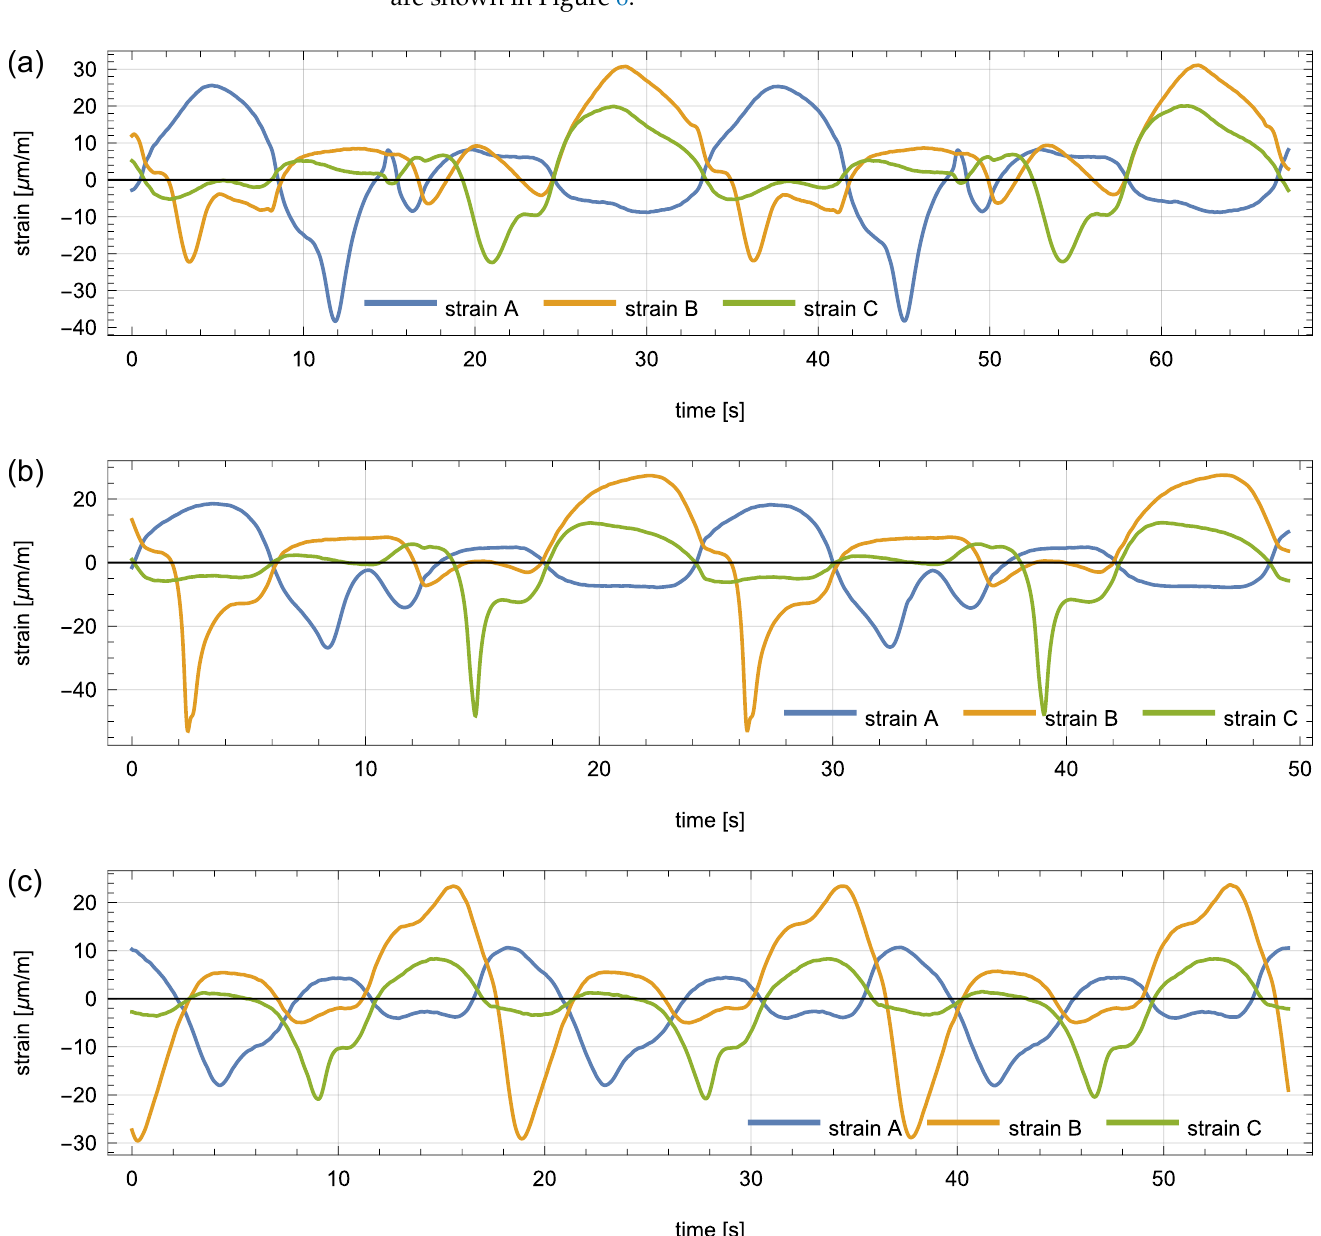
Figure 4. Recorded responses of the three involved strain sensors to the moving load (line-follower robot) following the test trajectories: ( a ) the square trajectory, ( b ) the circular trajectory, and ( c ) the triangle